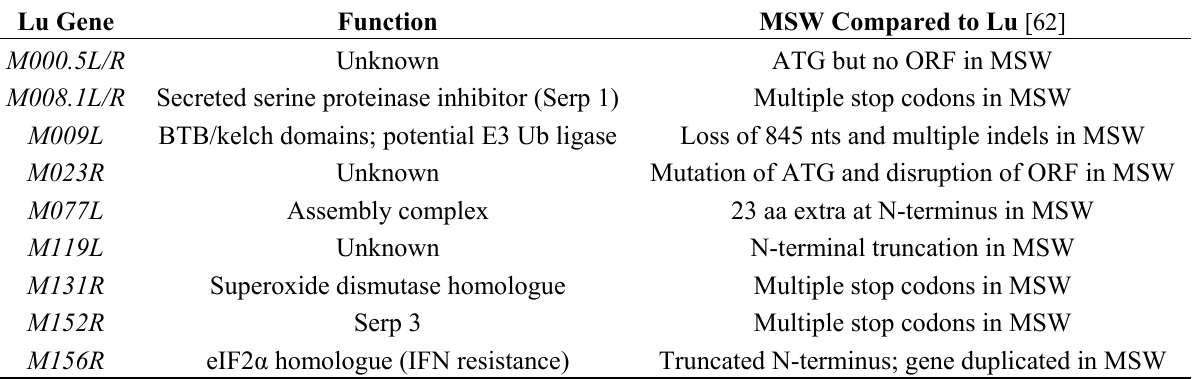
Table 4. Genes missing or substantially modified in MSW compared to